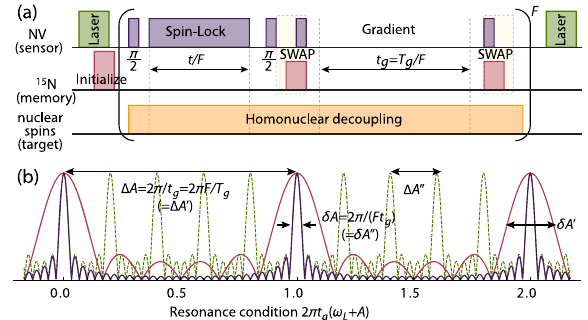
FIG. 2. (a) Control scheme for filtered cross-polarization nuclear spin sensing. Polarization is transferred from the NV electronic spin to the target nuclear spins in the biomolecule for a time t=F . To increase spatial resolution, the nuclear spins are allowed to evolve under a magnetic field gradient for a time ¼ T t =F , while the NV state is stored in the nuclear 15 N spin. g g The scheme is repeated F times to create a sharp filter. For reverse sensing, the two π = 2 pulses are omitted. (b) The filter created by the control scheme as a function of the normalized ð ω þ A Þ . The filter peaks are sharper for higher F time 2 π t g L (dark line, F ¼ 30 ; red line, F 0 ¼ 6 ), yielding a smaller line- width δ A . While it is possible to achieve sharper peaks at longer ¼ 5 t times (dashed line, F 00 ¼ 6 , t 00 ), this results in a smaller g g bandwidth Δ A 00 .